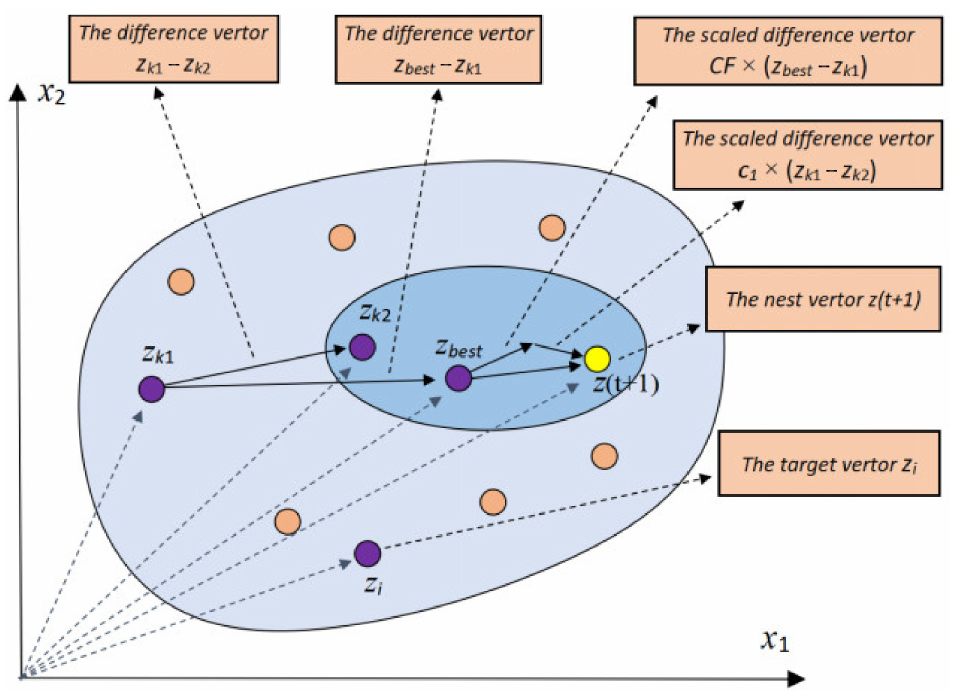
Figure 1. The introduction diagram of the interaction